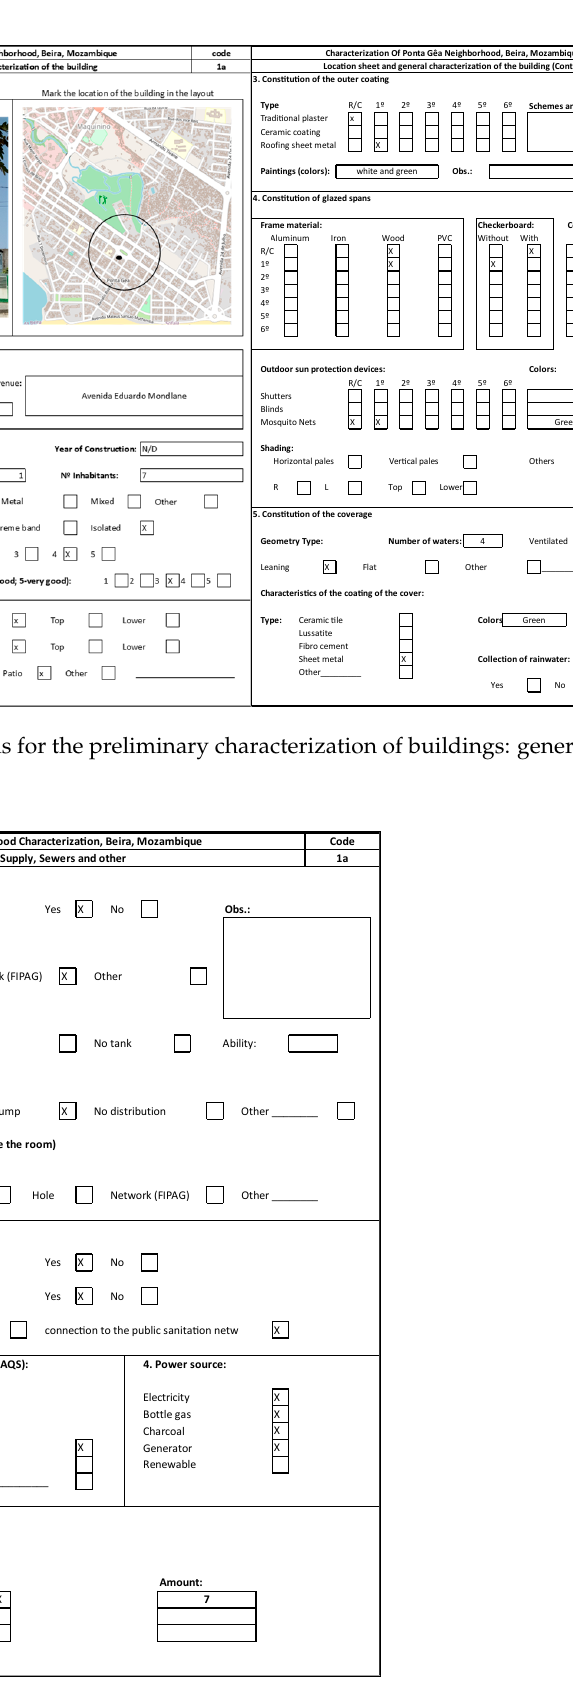
Figure 6. Survey forms for the preliminary characterization of buildings: water supply, sewers, and others.